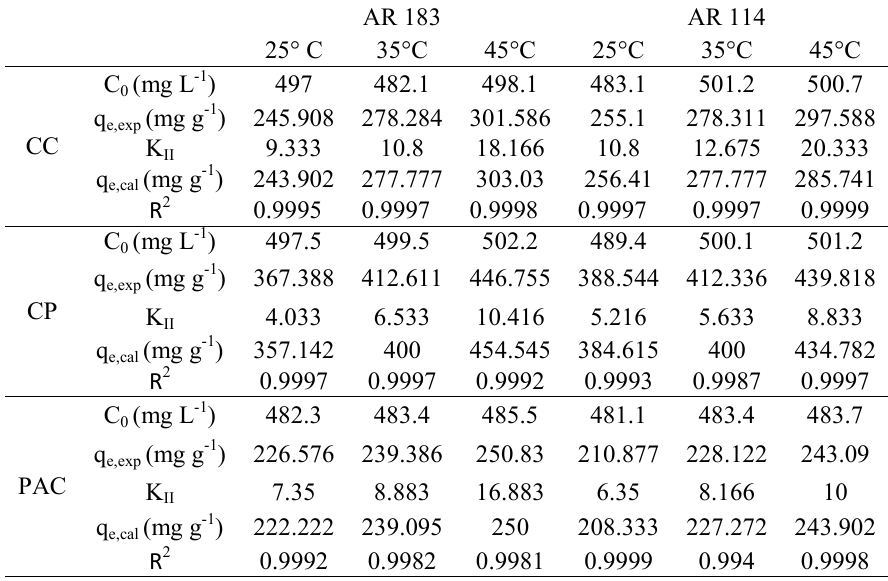
Table 2. Pseudo second-order rate constant, calculated and experimental q for initial AR concentration of 500 mg L - 1 .